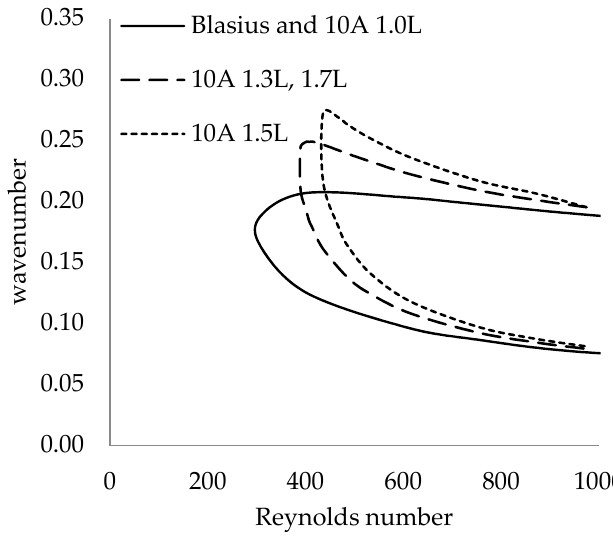
Figure 12. Neutral curves for a fixed 10% amplitude at different span locations.